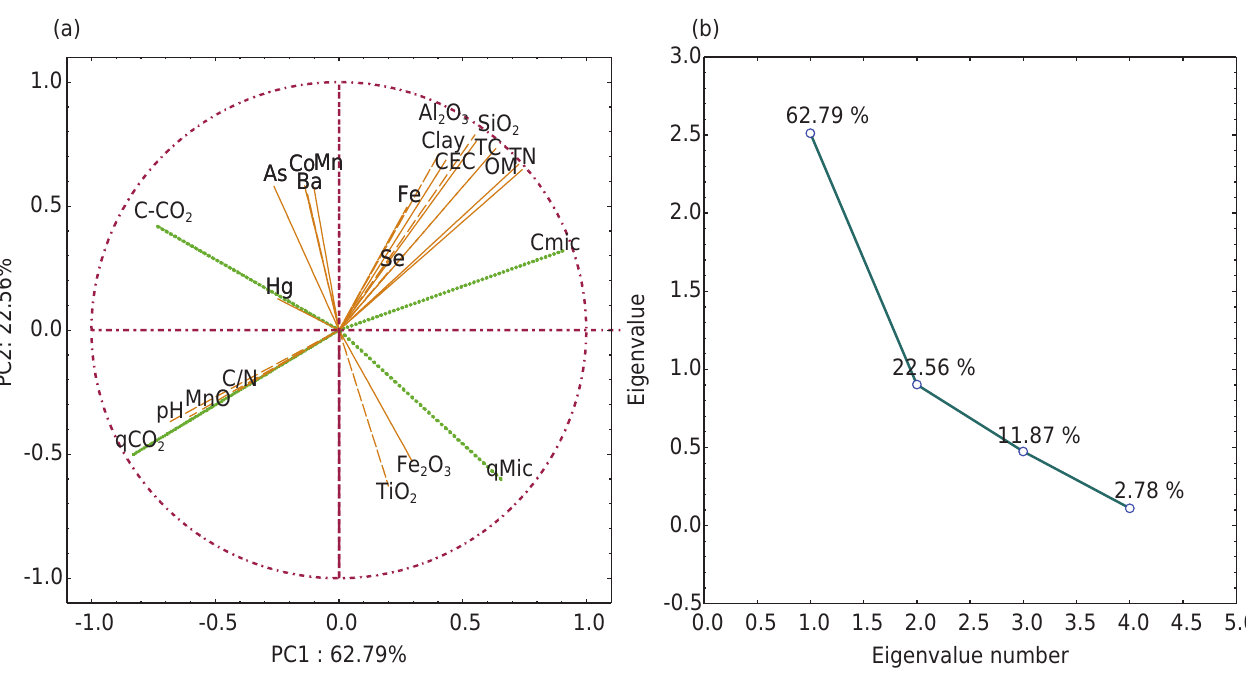
Figure 1. Principal component analyses between the available content of potentially toxic elements, cation exchange capacity (CEC) and biological properties of soil. OM: organic matter; TC: total carbon; TN: total nitrogen; Cmic: microbial biomass carbon; C-CO 2 :